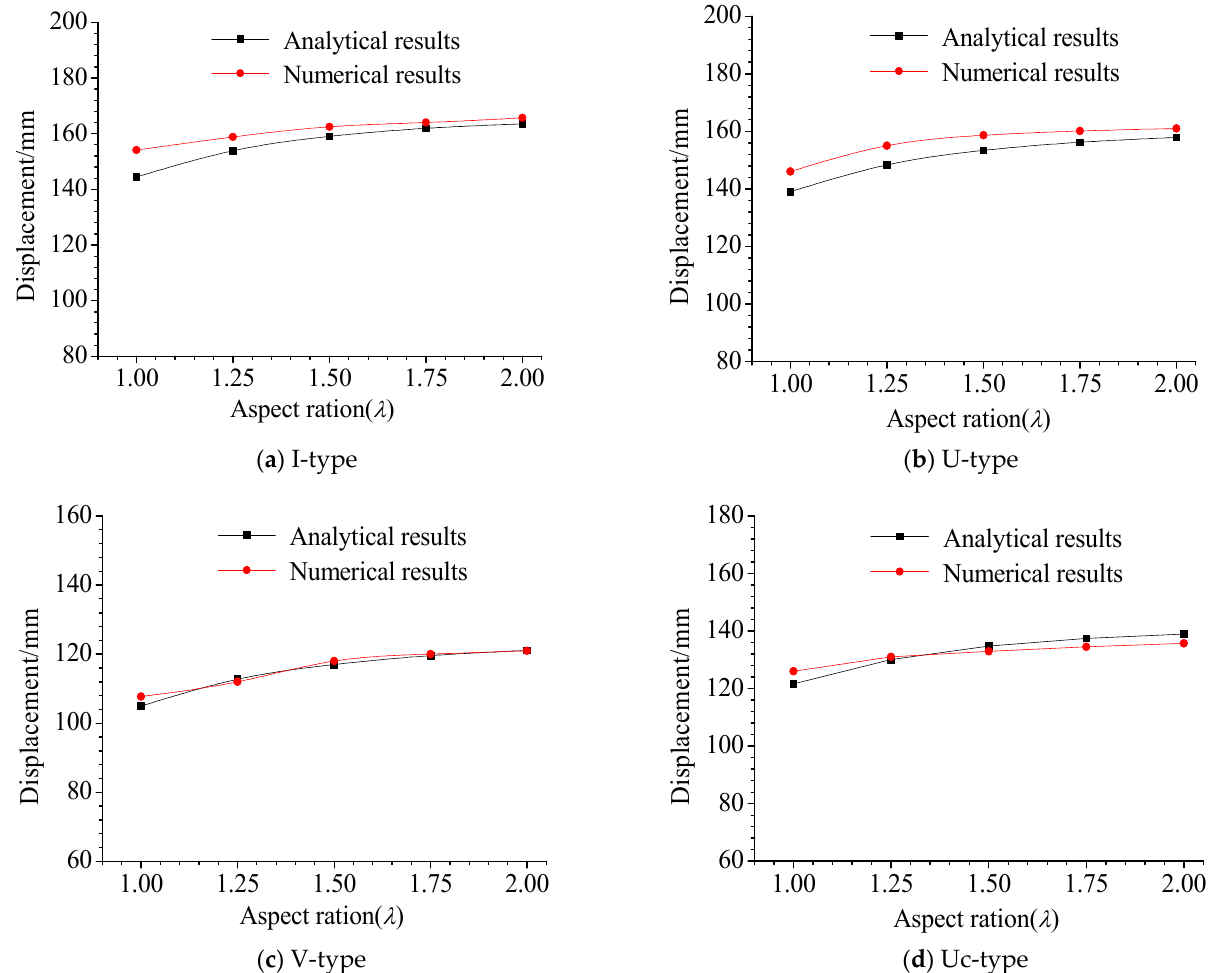
Figure 10. Comparison between the analytical results and numerical simulation results.